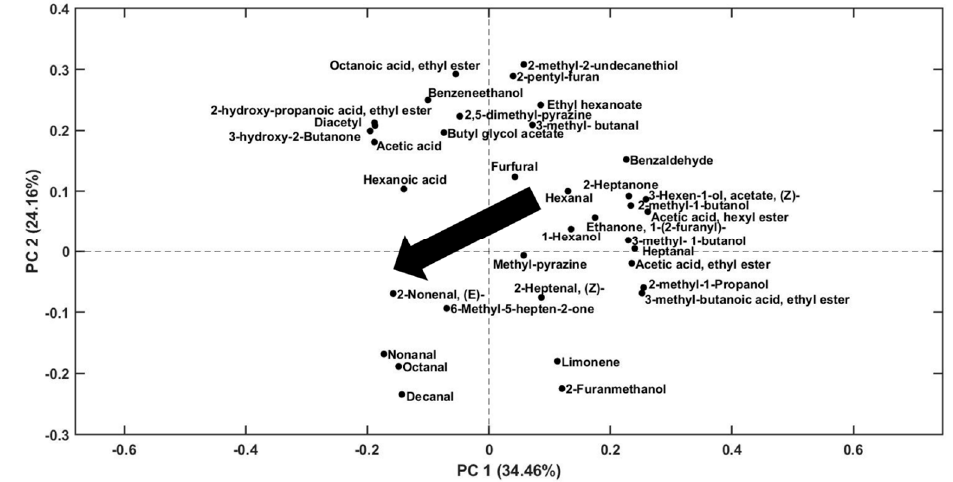
Figure 5. Analysis of VOCs of bread samples sampled with Arrow-SPME. PC1 vs. PC2 loadings plot obtained by PCA applied on selected areas from PARADISe analysis.